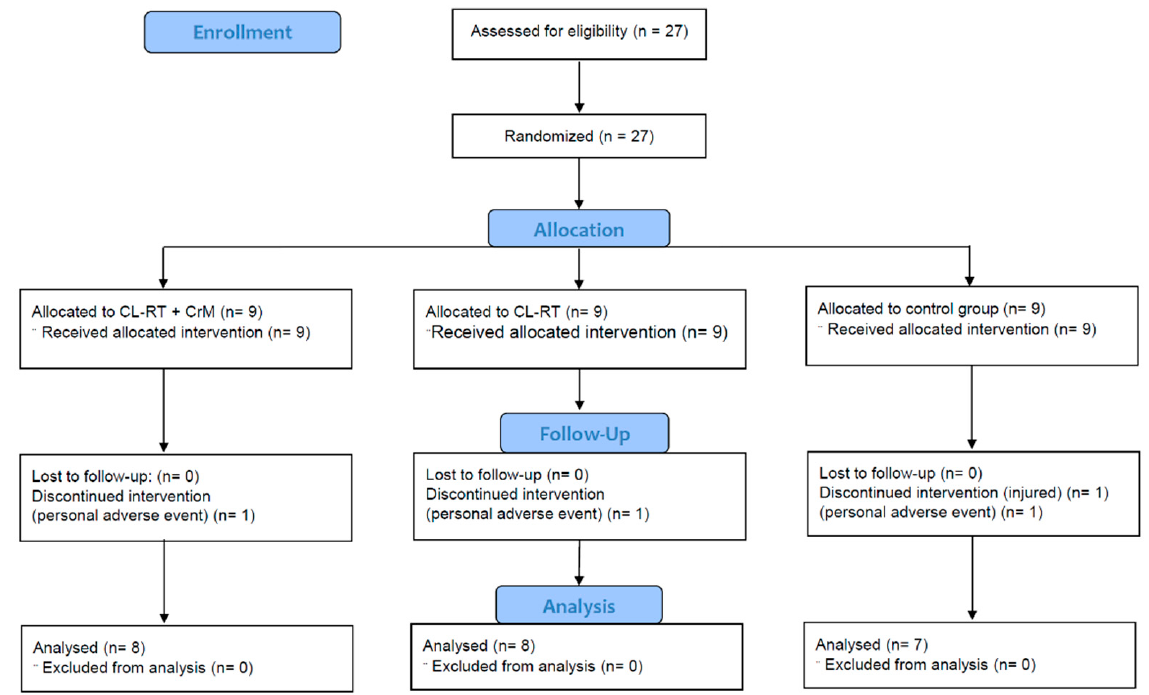
Figure 2. CONSORT flow diagram.